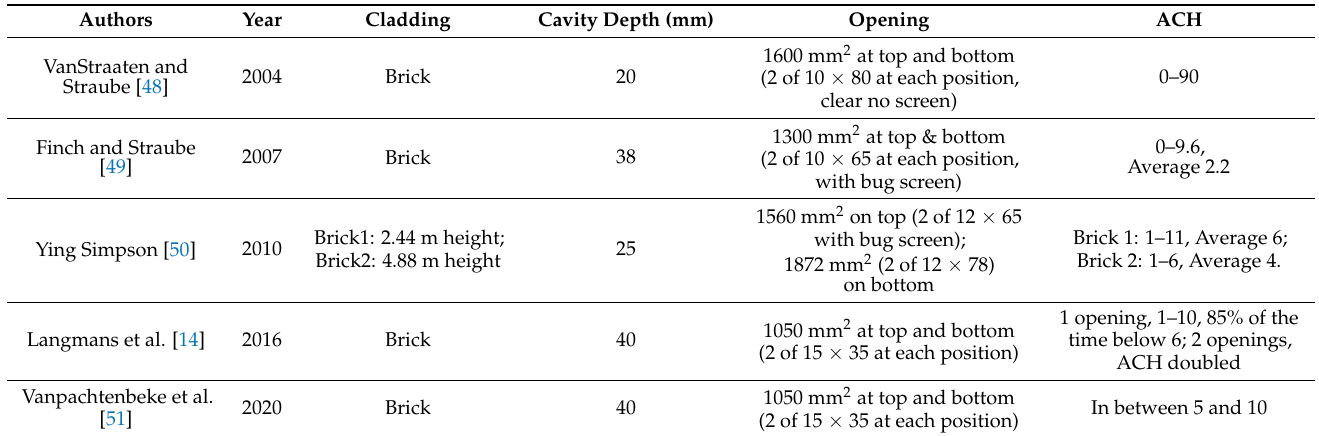
Table 6. Literature review on cladding ventilation